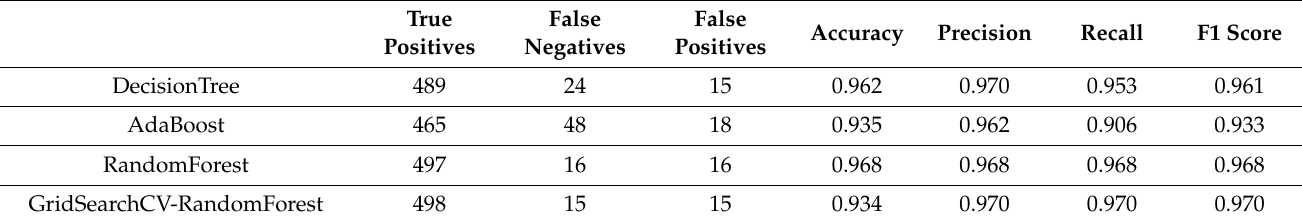
Table 8. Italy power demand dataset.